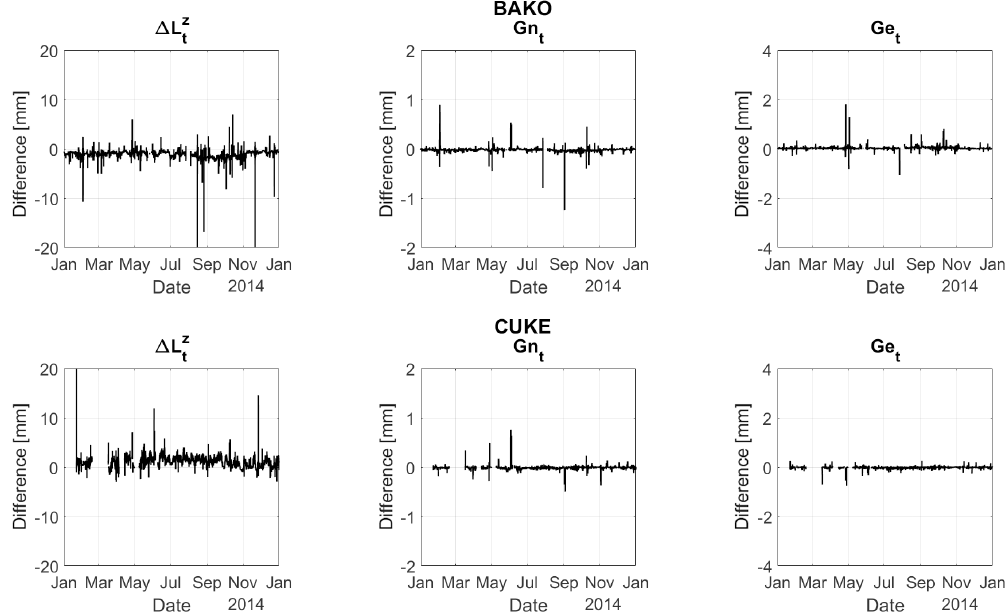
Figure 3. The differences of tropospheric parameters from VMF3 and GMF. Zenith wet delays and gradients (north and south) were esti- mated.